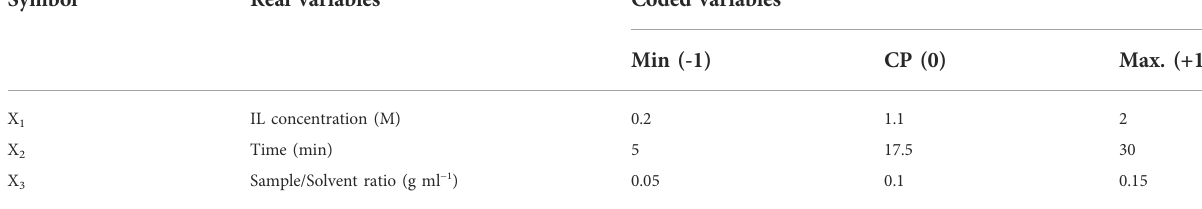
TABLE 2 Parameters used in Box-Behnken design for the optimization of MPW extraction. Symbol